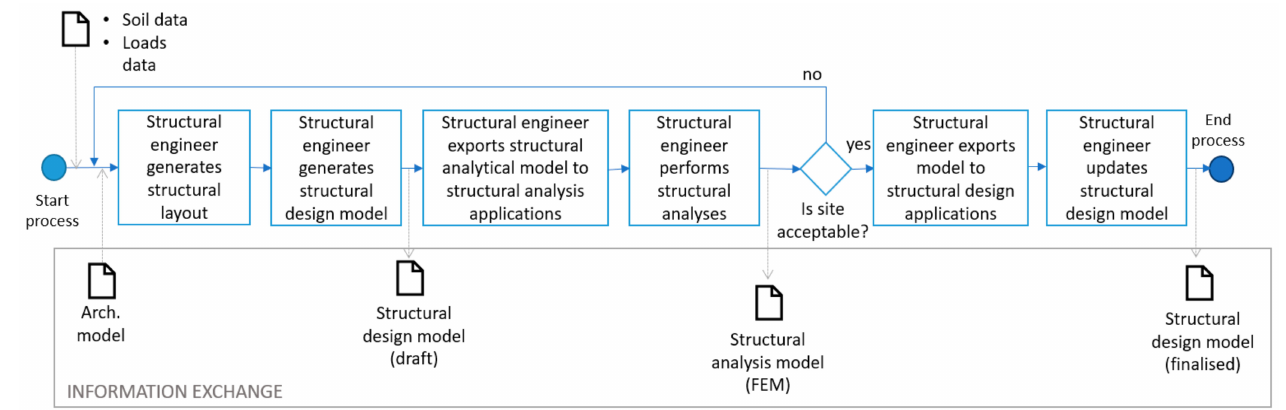
Figure 1. Reference workflow of BIM use (1)—structural